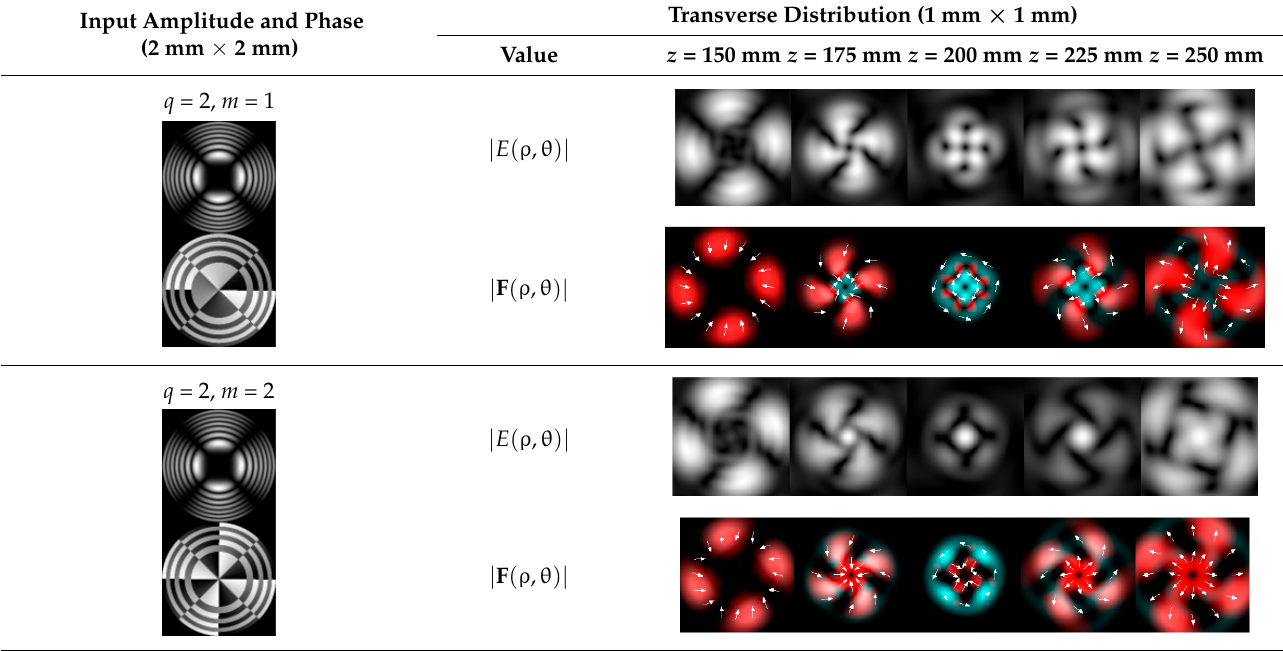
Table 3. Results of TEFD simulation for the field defined by Equation (18) with azimuthal modula- tion of order q = 2 and with different orders of additional vortex phase singularity m .